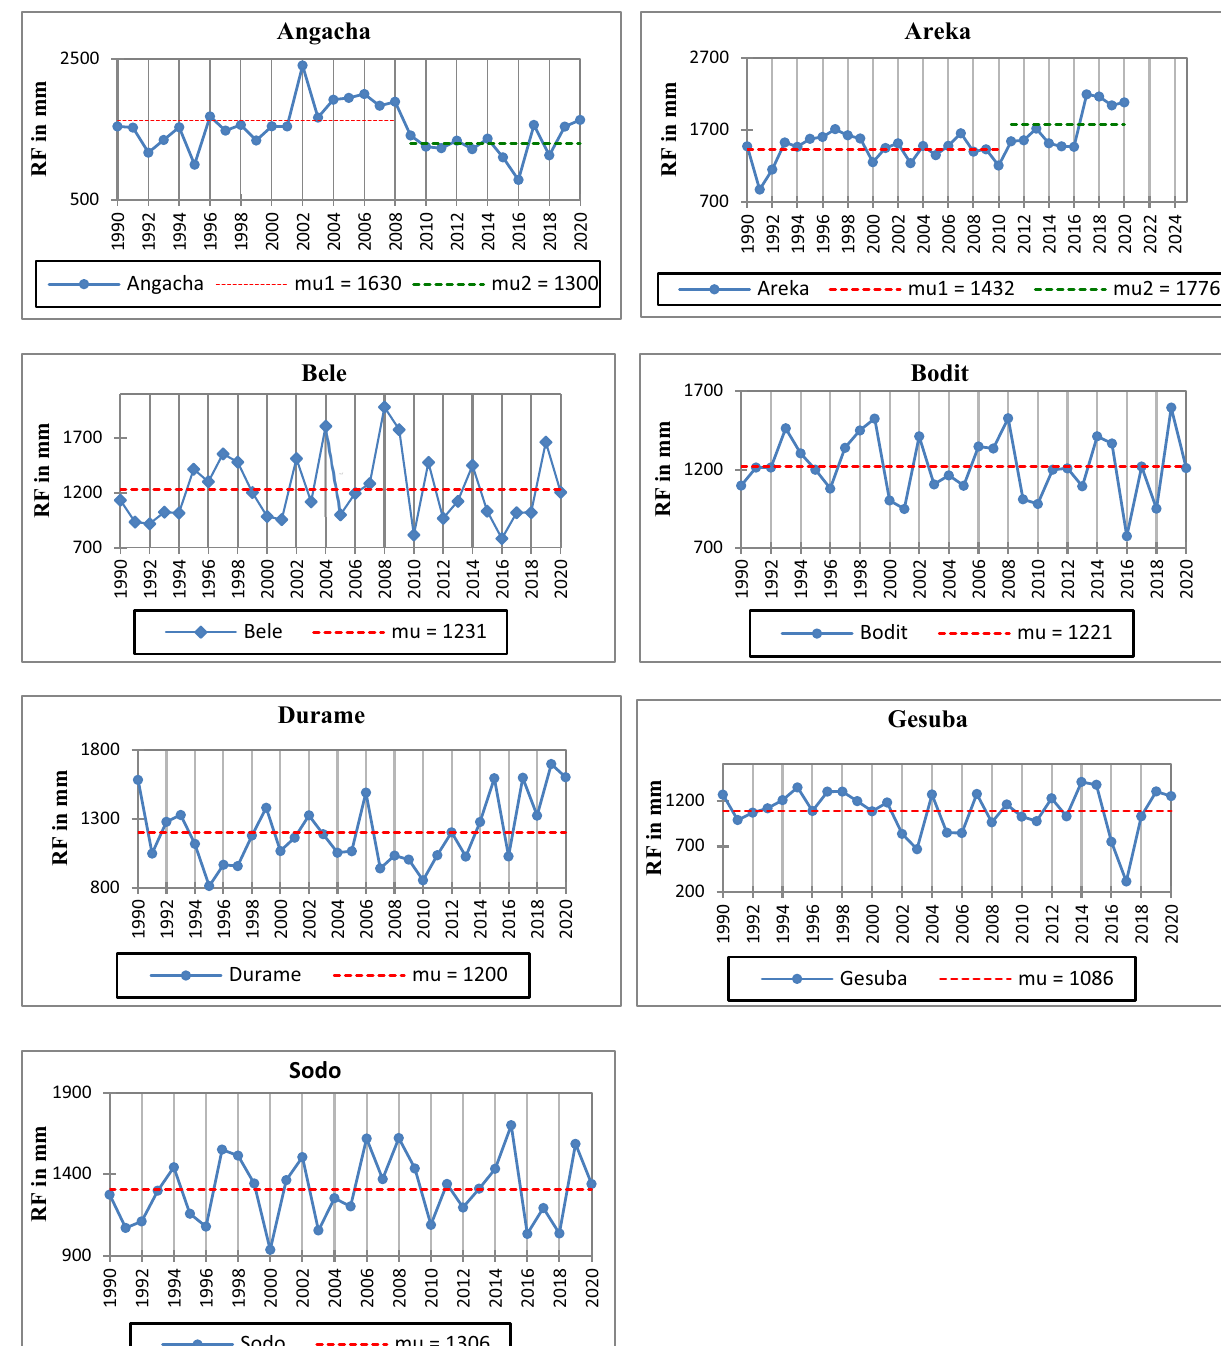
Fig. 3 Homogeneity test of the annual mean rainfall at seven stations, where mu is the annual mean rainfall (mm), mu 1 is the annual mean rainfall (mm) before the change point and mu2 is the annual mean rainfall (mm) after the change